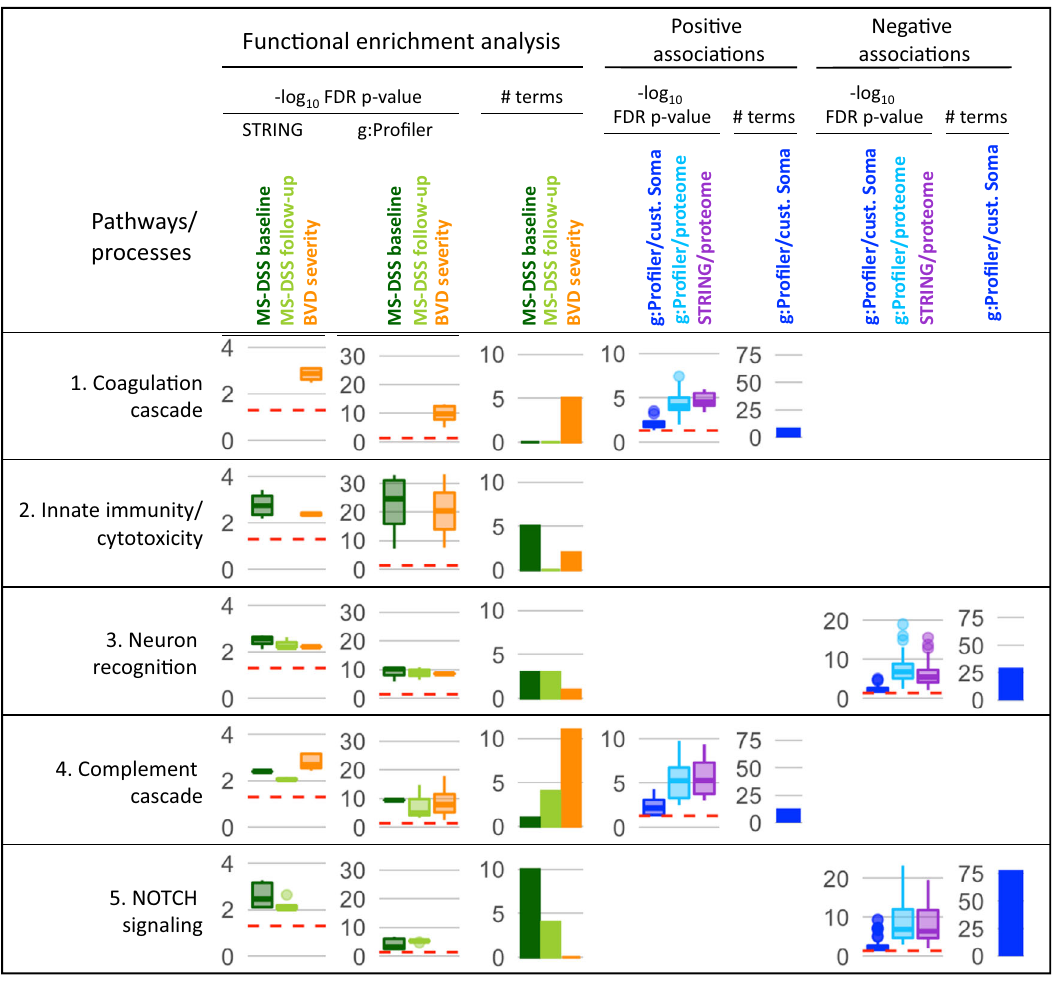
p -value<0.05) correlating with either of the three outcomes were submitted to g:Pro fi ler using the custom set of 1305 SOMAmers (dark blue) or the whole pro- teome (light blue) as analysis background. The same set of SOMAmers was also analyzed by STRING using whole proteome background (violet). Boxplots of p - values for signi fi cantly enriched processes are displayed, as well as the number of signi fi cantly enriched processes that the g:Pro fi ler identi fi ed linked to MS severity outcomes using 1305 SomaScan proteins as a background. FDR-adjusted p -values aredisplayedona – log 10 scale,thereddashedlinedepictstheFDR-adjusted p -value of 0.05. The lower and upper hinges of the boxplots correspond to the fi rst and thirdquartiles(the25thand75thpercentiles).Theupperwhiskerextendsfromthe hinge to the largest value no further than 1.5*interquartile range (IQR) from the hinge. The lower whisker extends from the hinge to the smallest value at most 1.5*IQR of the hinge. Source data are provided as a Source Data fi